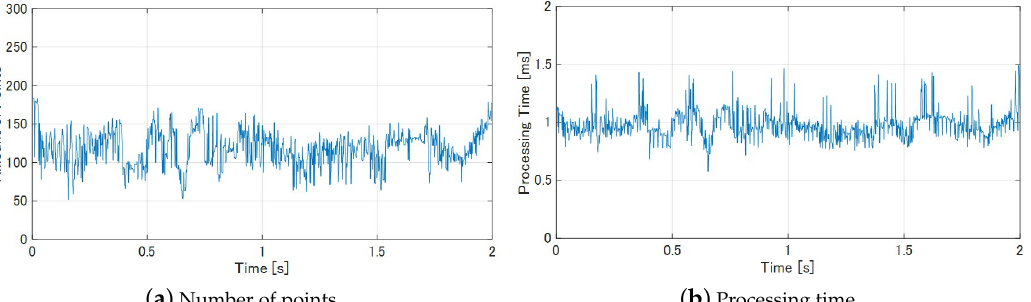
Figure 13. Result of model